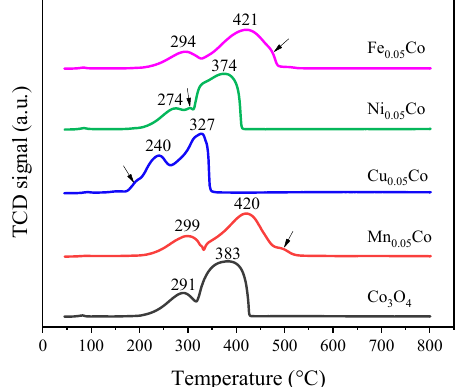
Figure 5. H 2 -TPR profiles of the Co 3 O 4 and M 0.05 Co catalysts.